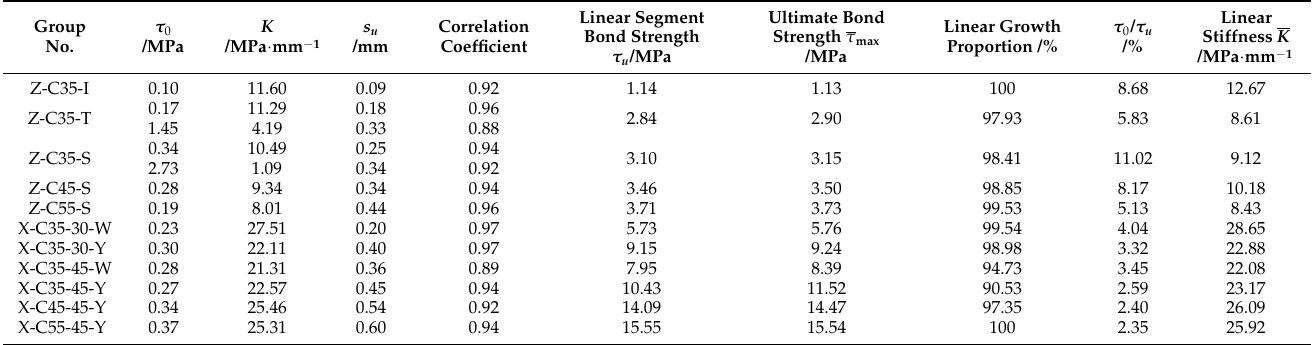
Table 6. Parameters related to the interface bond–slip